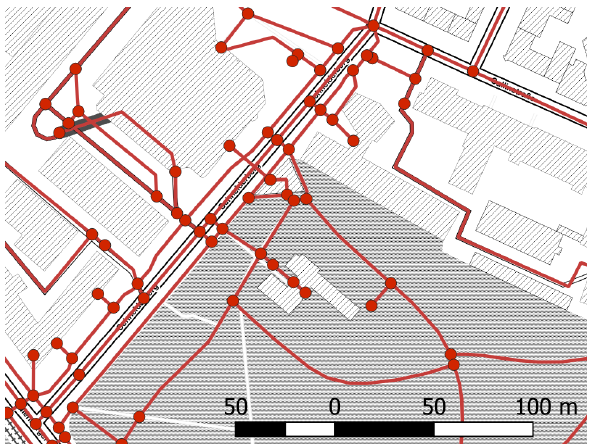
Figure 3. Example of the used way network routing graph. Including a park on the bottom right and a residential street with separately modeled road and bike ways. (base map by